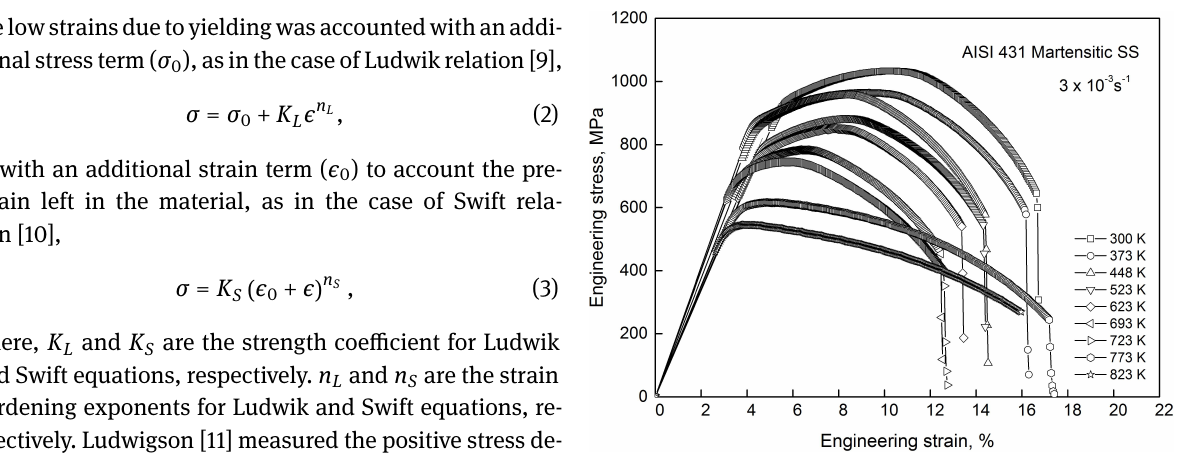
Figure 1: Variation of engineering stress as a function of engineering strain for the AISI 431 steel in the temperature range of 300-823 K.